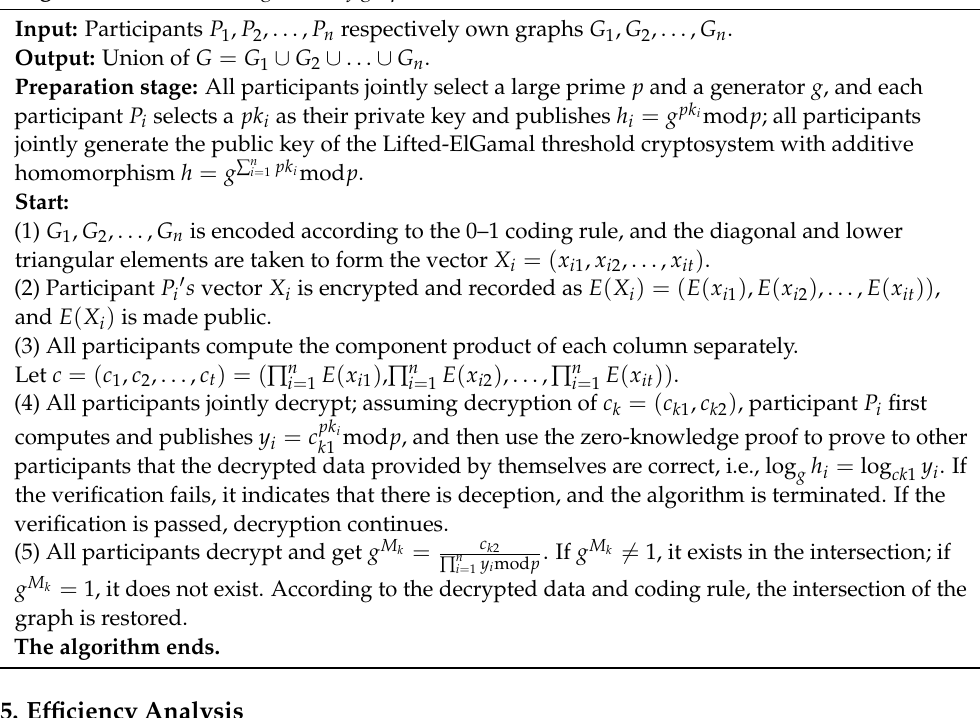
Algorithm 3. The MPC algorithm of graphs’ union under the malicious model